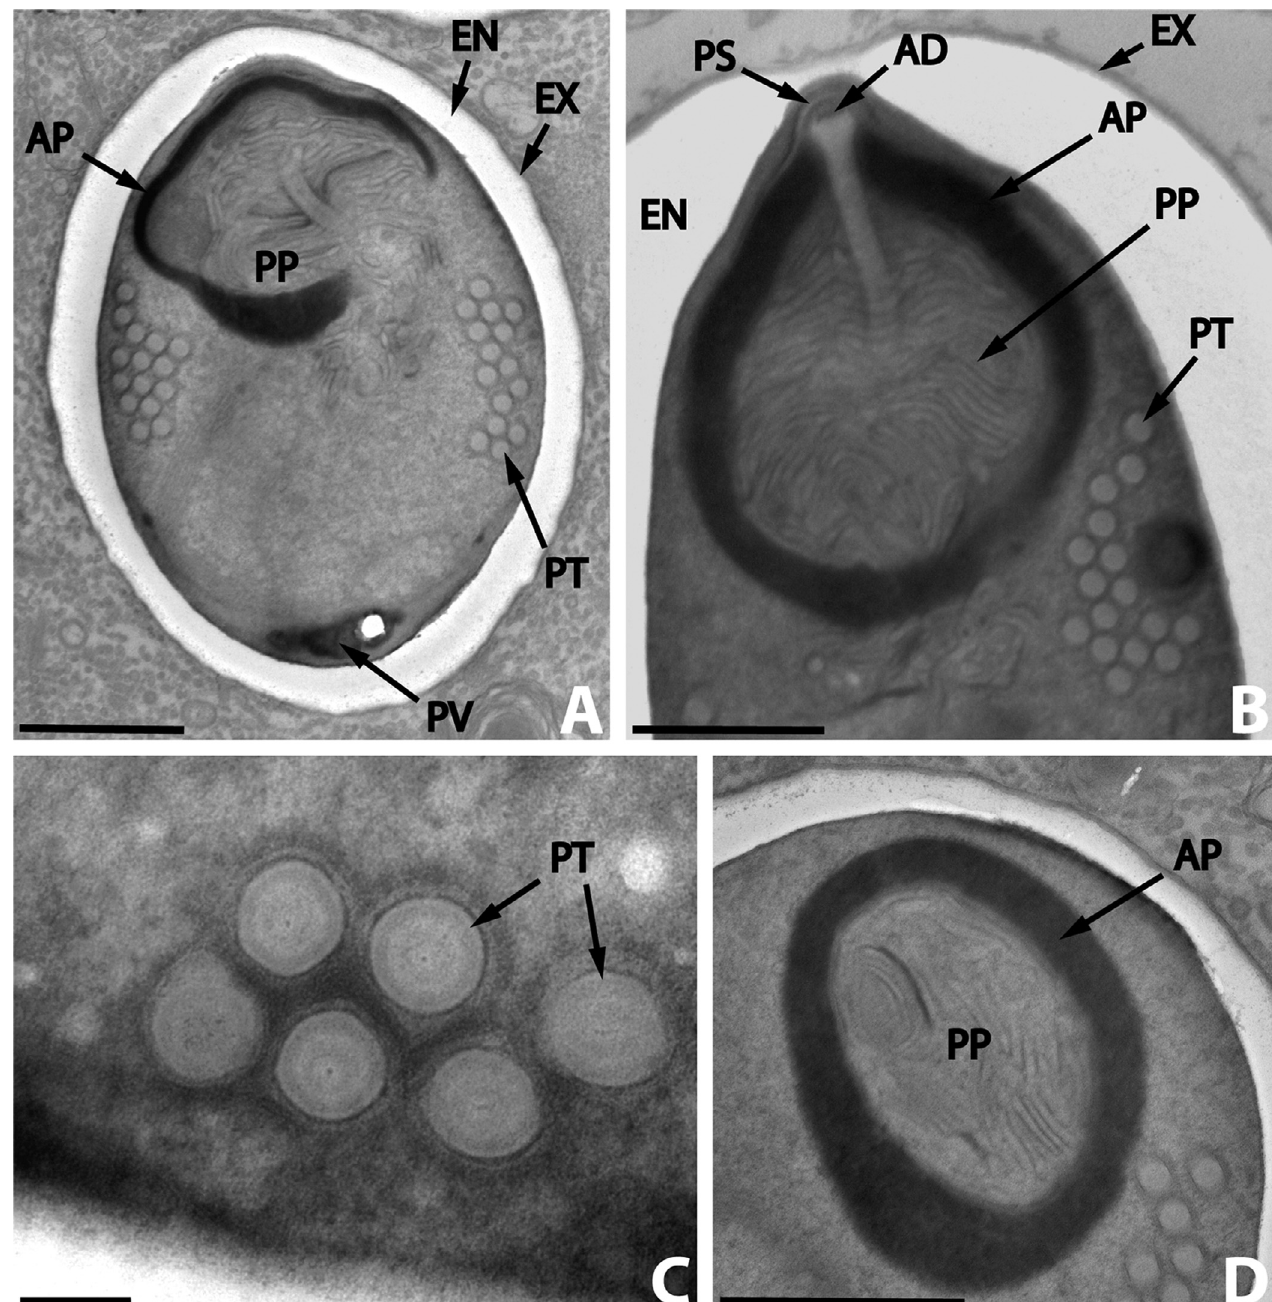
Figure 4. Nosema podocotyloidis n. sp. A. Mature spore with 15 coils of polar tube. B. Detail of the anterior region of a mature spore showing the anchoring disc (AD) and the polar sac (PS). C. Transversally sectioned polar tube coils revealing the different layers. D. Detail of the polaroplast revealing the structure of the outer or anterior region (AP) and of the inner or posterior region (PP). AP: anterior polaroplast; EN: endospore; EX: exospore; PT: polar tube; PP: posterior polaroplast; PS: polar sac; PV: posterior vacuole. Scale Bars: A, B and D, 1 l m; C, 0.1 l